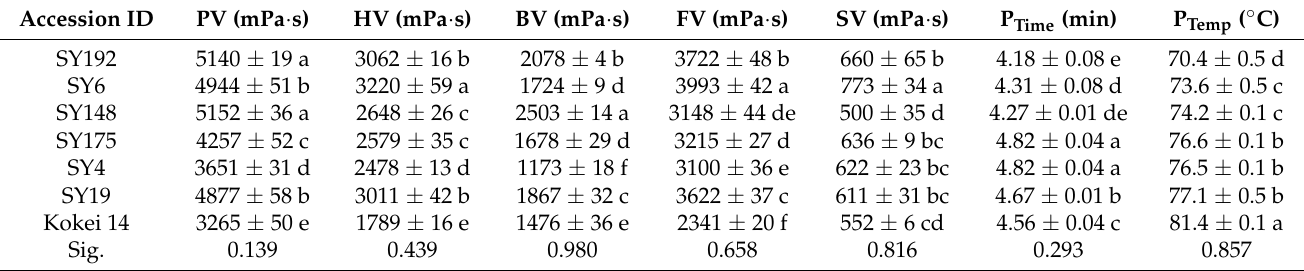
Table 6. Pasting property parameters of C-type starches from different sweet potato varieties.